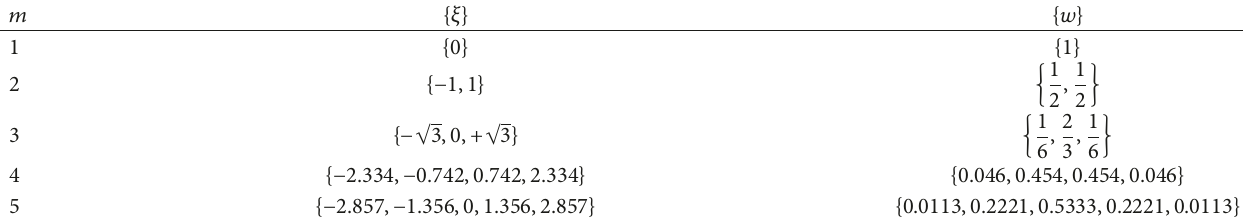
1 {1 2, 2} 2 1 {1 6, 3, 6}